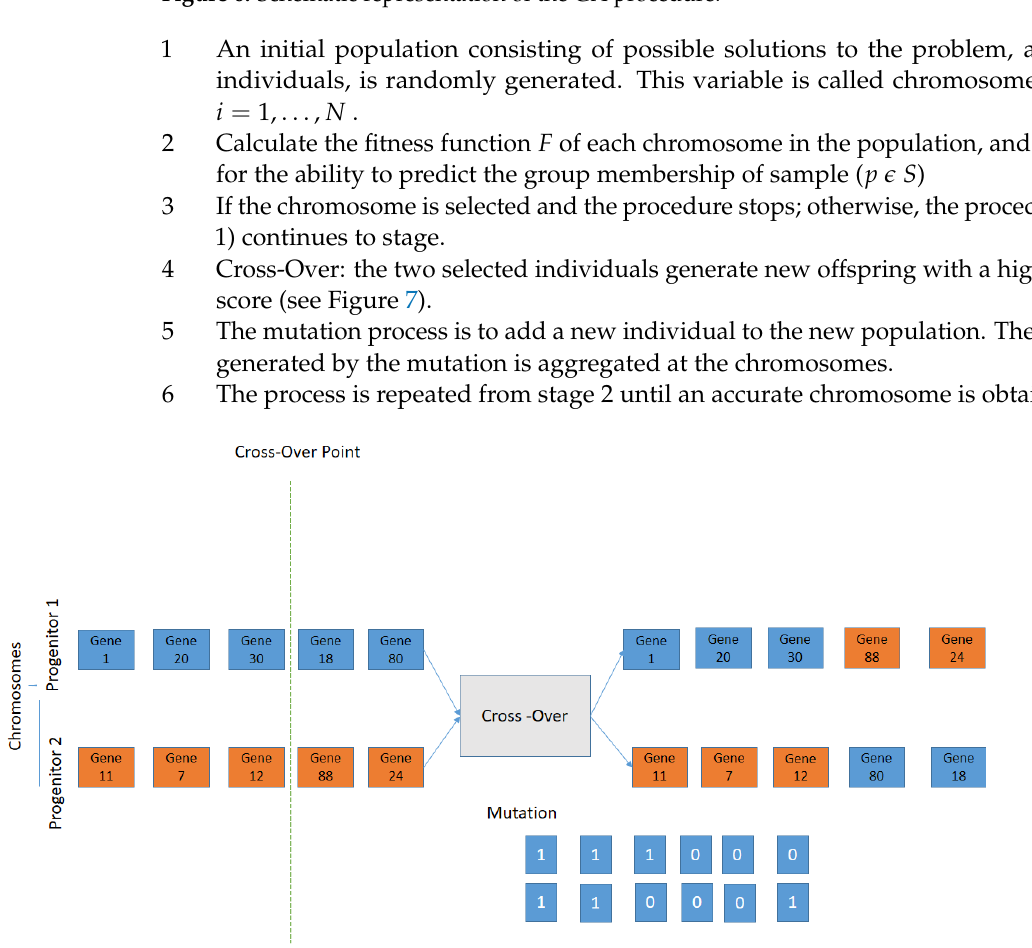
Figure 6. Schematic representation of the GA procedure.